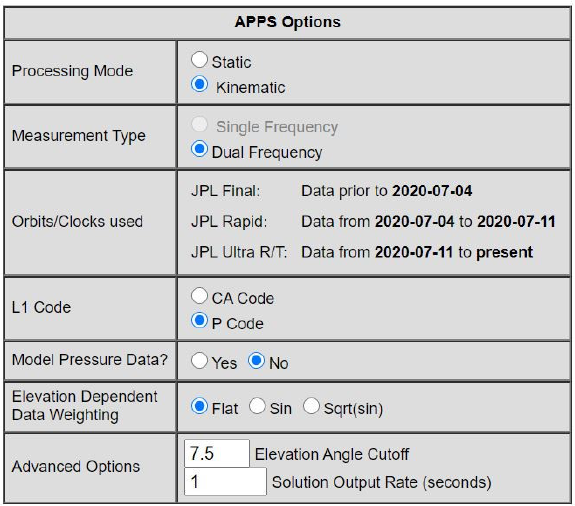
Fig. 5. Data processing parameters used in APPS.